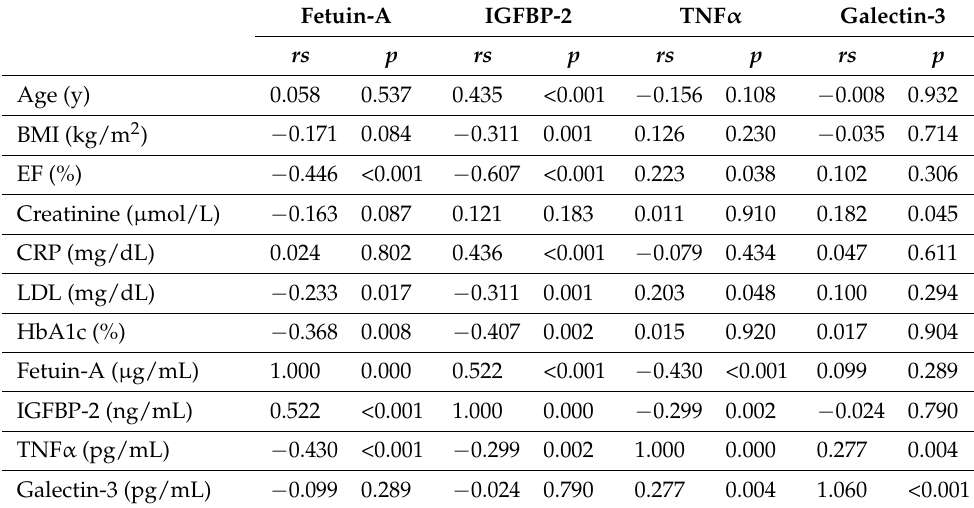
Table 2. Bivariate correlation and point-biserial correlation analysis of baseline characteristics and biomarkers. Fetuin-A